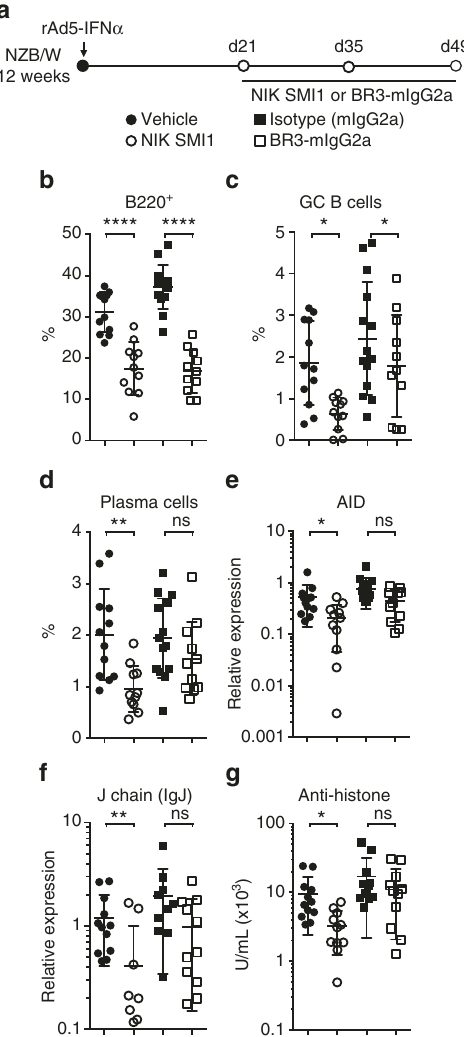
Fig. 5 NIK inhibition reduces B cell function in NZB/W F1 mice. a Experimental design. Lupus prone NZB/W F1 mice were accelerated with adenovirally delivered IFN α and treated with NIK SMI1 or BR3-mIgG2a or appropriate controls for 4 weeks. b – d Percentage of B220 + ( b ), germinal center (GC) B cells (B220 + IgM - IgD − GL7 hi CD95 + ) ( c ), and plasma cells (B220 − CD138 + ) ( d ) of live splenocytes. e , f Splenic gene expression as determined by Fluidigm technology of AID ( e ) and IgJ ( f ). g ELISA measurement of serum autoantibodies against histone. Data represented as mean ± standard deviation from 9 – 11 mice per group. Statistics: Krushal – Wallis test with Dunn ’ s test for multiple comparisons. * p <